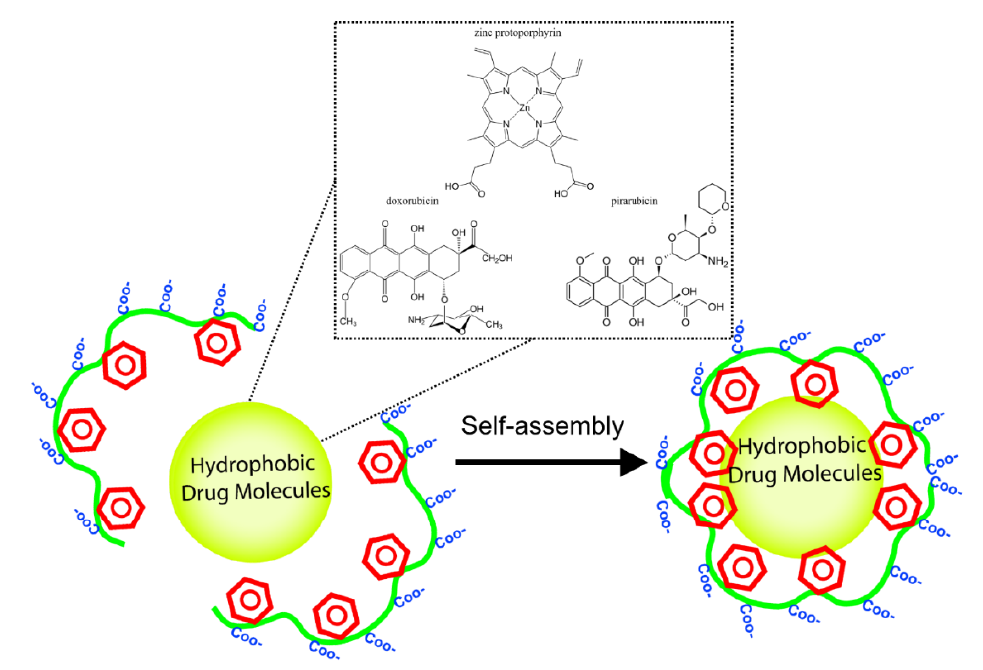
Figure 4. Styrene-maleic acid copolymers were efficient vehicles for encapsulation of hydrophobic drug-like molecules such as doxorubicin, zinc protoporphyrin, pirarubicin.